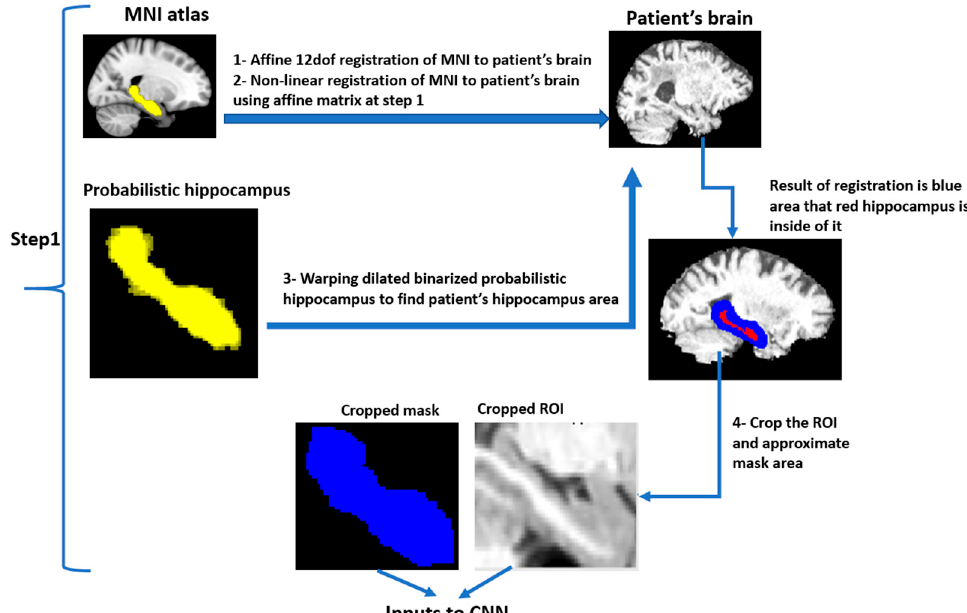
Figure 1. Atlas-based segmentation of the hippocampus involves the following sequential processes: (1) linear alignment of the Montreal Neurological Institute (MNI) brain atlas to the individual brain scans; (2) non-linear registration of the MNI atlas to the T1-weighted image; (3) warping the dilated binarized mask of the hippocampus to the patient space; and (4) cropping the region of interest.